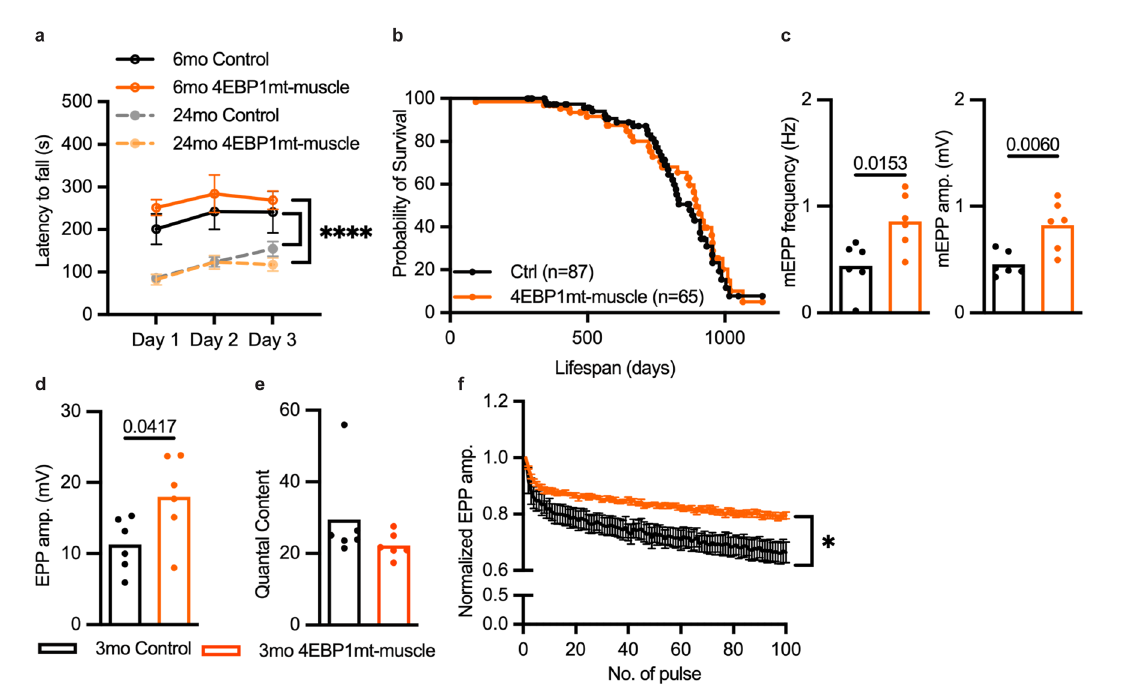
Fig. 5 | 4EBP1 activation enhances neuromuscular synaptic transmission. a Motorcoordinationperformanceasmeasuredbytherotarodin6-and24-month- old male mice over a 3-day period (6mo Control and 4EBP1mt-muscle, n =5 per group; 24mo Control, n =9; 24mo 4EBP1mt-muscle, n =7. Data are presented as mean values±SEM. **** P <0.0001 and statistical signi fi cance was determined by two-wayANOVAfollowedbyTukey ’ spost-hocpairwisecomparisonof6-versus24- month-old mice within indicated genotype. b Lifespan of male 4EBP1mt-muscle mice versus their littermate controls (Control Male, n =87, 4EBP1mt-muscle Male, n =65). The comparison of survival rates between groups was examined by Log- rank (Mantel – Cox) test. The median lifespans of the control and